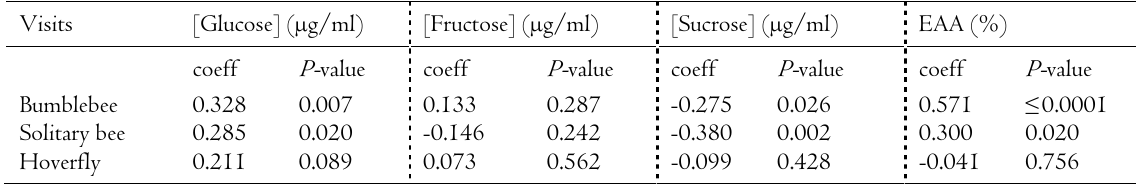
Table 2. Relationships between plant reward (sugar concentrations/relative abundance of EAA (%) and visits (per flower per hour) for each insect